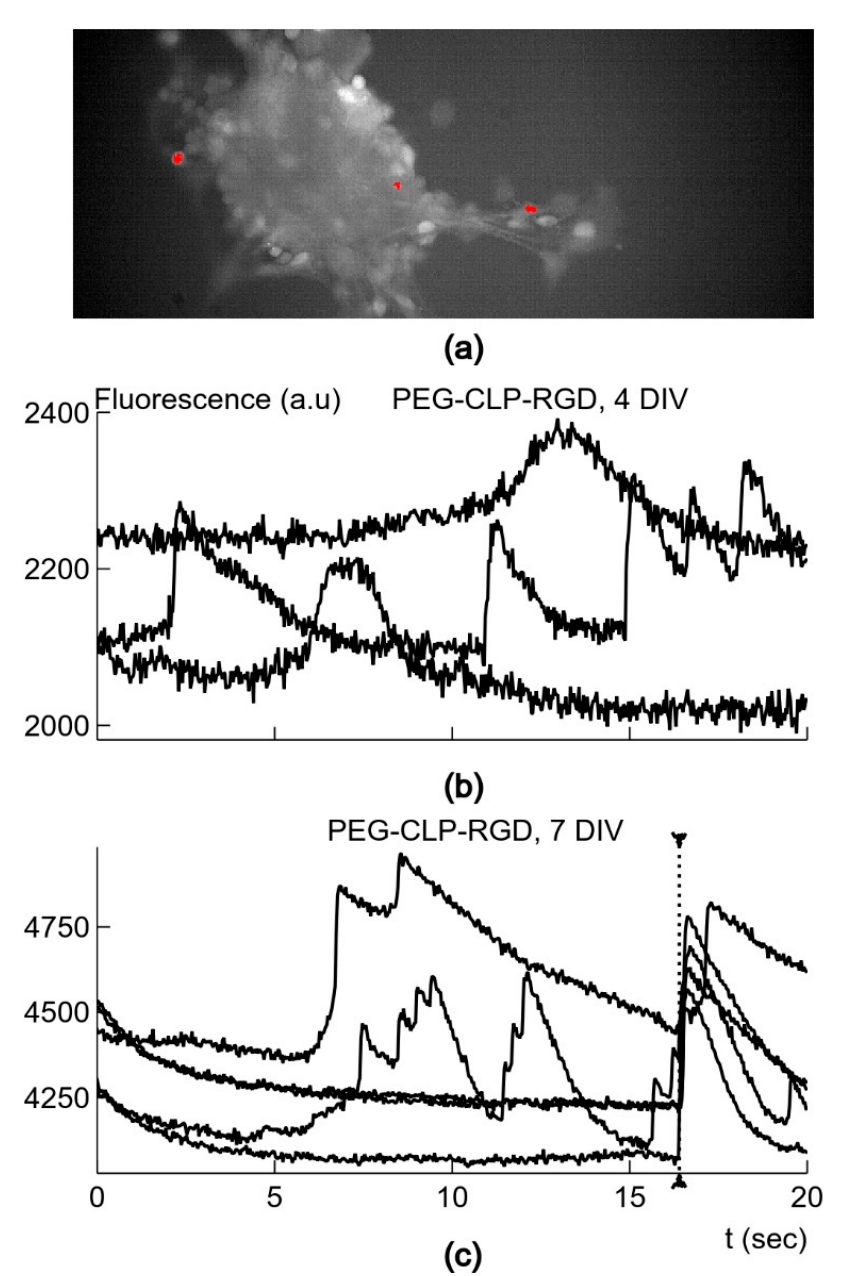
Figure 7. ( a ) Fluorescence image of culture after 4 days on a PEG-CLP-RGD hydrogel membrane with spontaneously active neurons (in red). ( b ) Traces of spontaneous fluorescence changes from 3 di ff erent neurons marked in ( a ) and recorded simultaneously. ( c ) Fluorescence traces from 5 di ff erent neurons after DIV7 on a PEG-CLP-RGD hydrogel membrane; dotted line marks apparent synchronization between neurons. In ( b ), the time axis is the same as in ( c ).